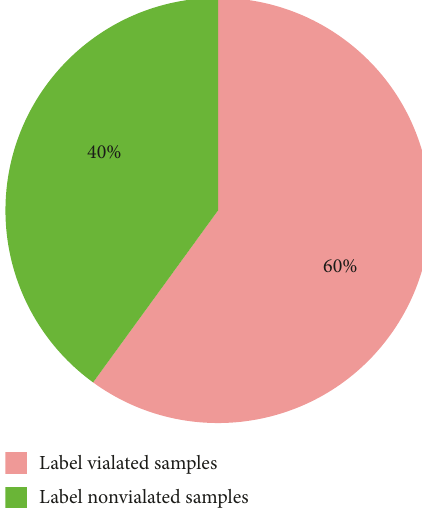
Figure 6: Label violation of beverages collected in Jaffna district as percentage. Table 3: TLC analysis of beverage samples in Jaffna